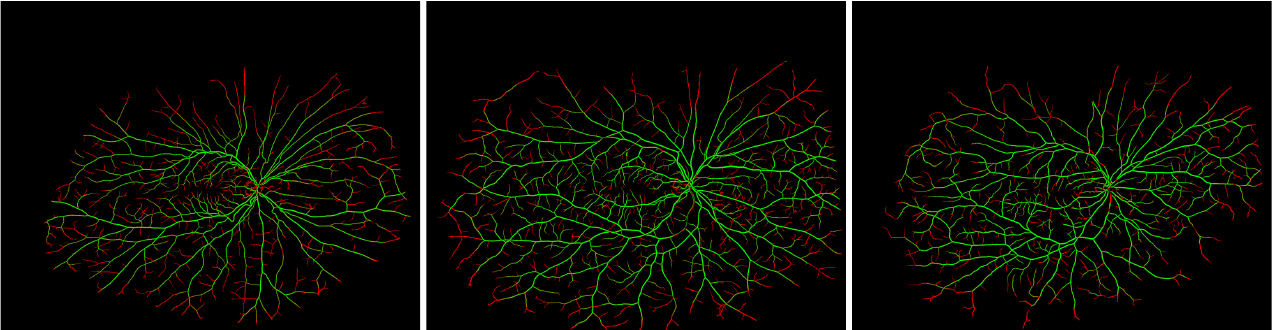
Figure 11. Exemplary vasculature segmentation results on images without the preprocessing by the proposed method (green) and after being processed by the proposed method (red).